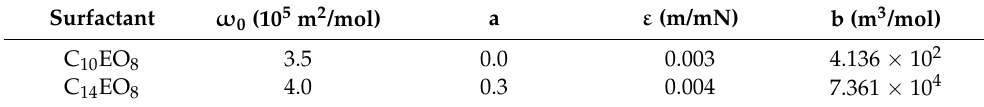
Table 2. Parameters of the isotherms of C n EO m solutions for the Frumkin model.